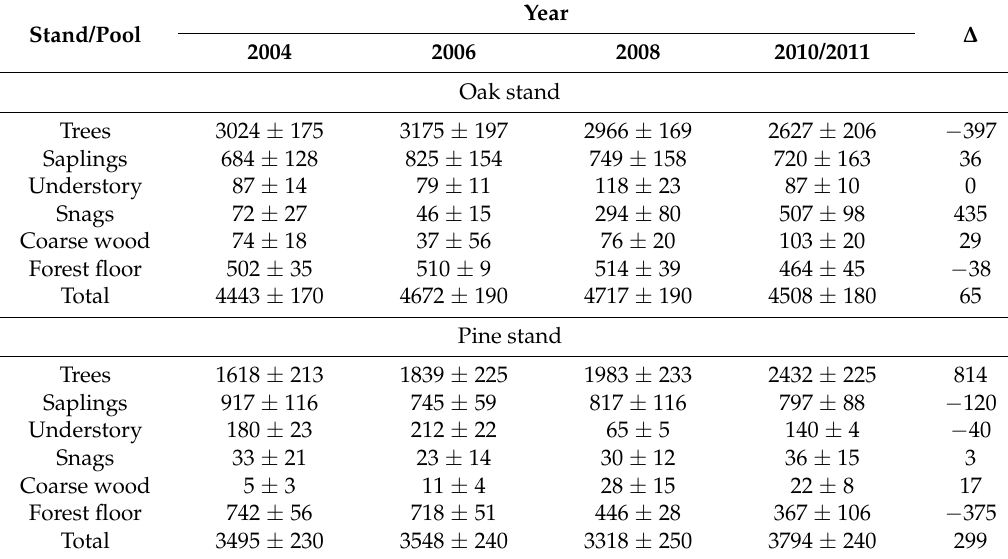
Table A3. Summary of carbon pools estimated for Forest Inventory and Analysis (FIA)-type and tower plots at the oak and pine stands. Above-ground and coarse root biomass of trees and saplings, and standing dead and coarse woody debris mass data are from the FIA-type plots ( n = 16 for the oak stand n = 12 for the pine stand) distributed over 1 km 2 , and understory biomass and forest floor mass are from the tower plots ( n = 5 for each stand). Values are mean g C m − 2 ± 1 SE. ∆ is the change in biomass or mass between 2004 and 2010 (oak stand) or 2011 (pine stand).